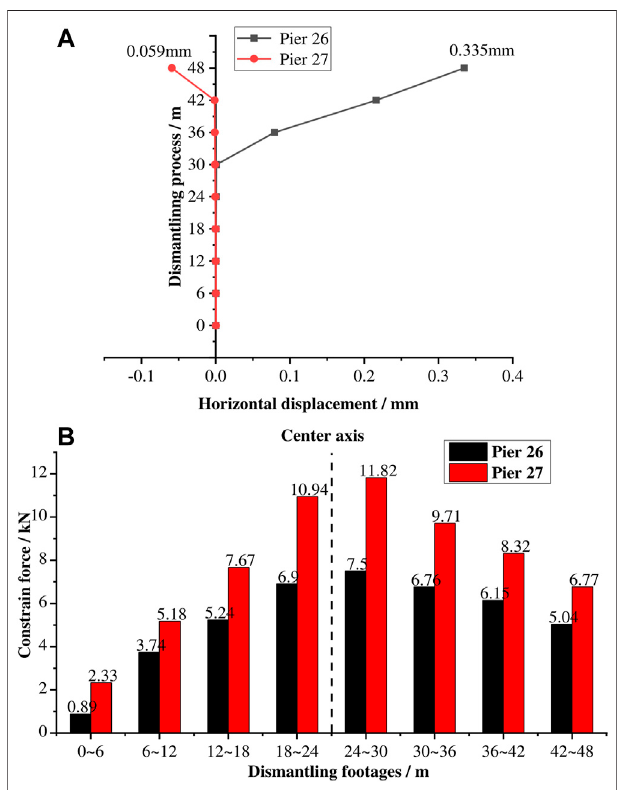
FIGURE 6 | Horizontal displacement and restraining reaction forces of the top of pier 26 and 27 during the dismantling process of temporary lining: (A) Horizontal displacement; (B) Restraining reaction forces induced by sectional